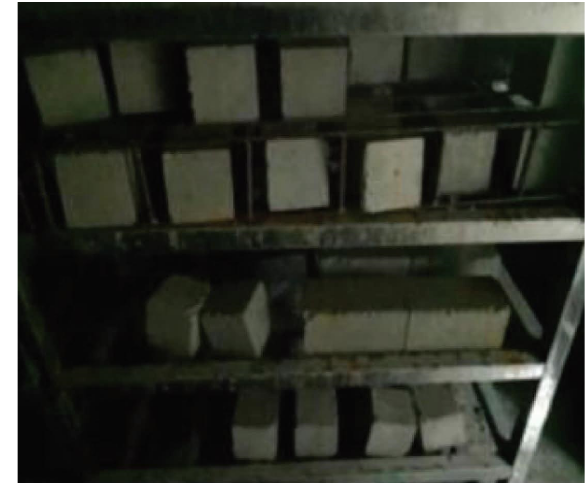
Figure 3: Fly ash